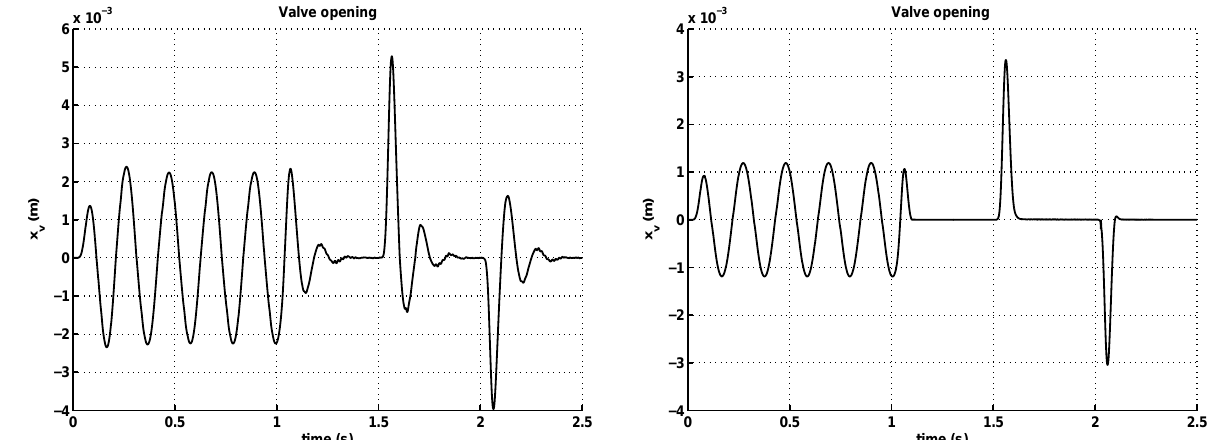
Figure 10: Input (valve opening) with the controller of section